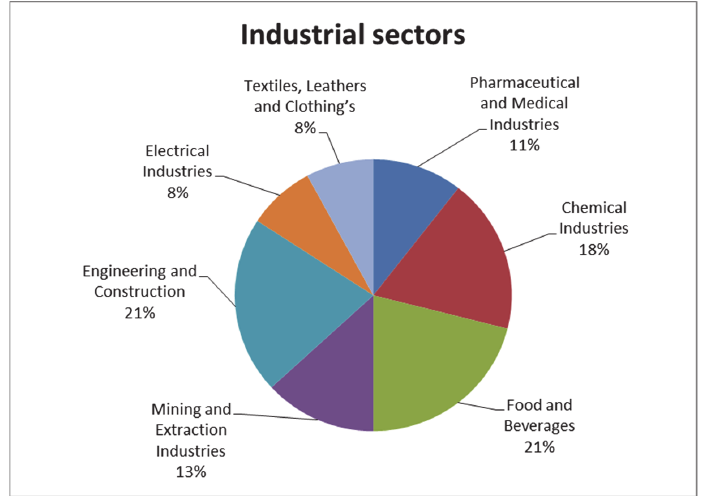
Fig. 2. Percentage of each industrial sector in the